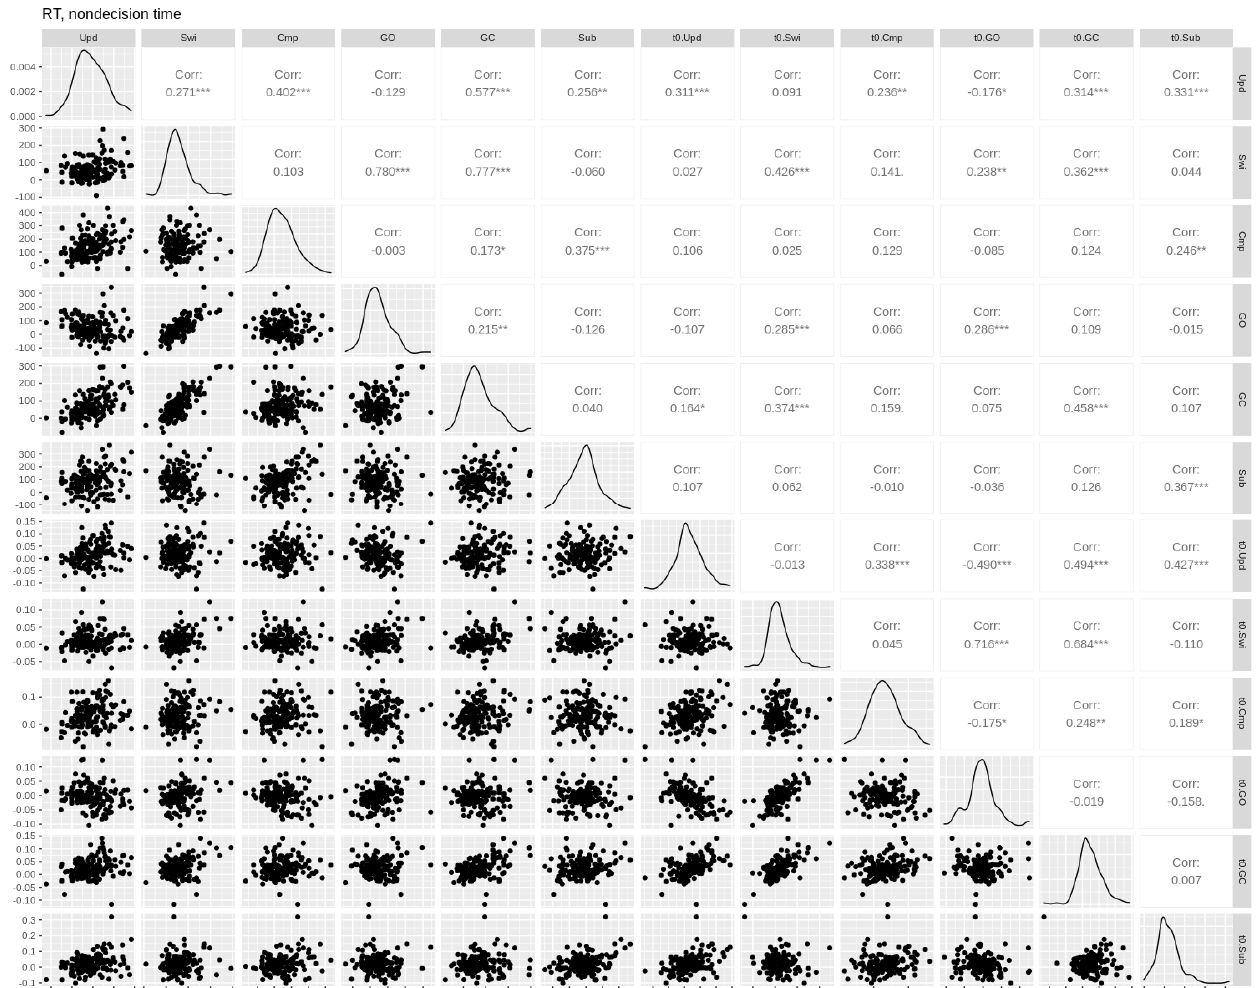
Figure A5. Pairwise Pearson correlations between non ‐ decision time and RT cost effects. Empirical effects are shown in the first six columns. Parameter effects are shown in the last six columns (prefixed with the parameter name). Upd = updating, Swi = switching, Cmp = comparison, GO = gate opening, GC = gate closing, Sub = substitution. Asterisks *, **, and *** denote p ‐ values of <0.05, <0.01, and <0.001, respectively.